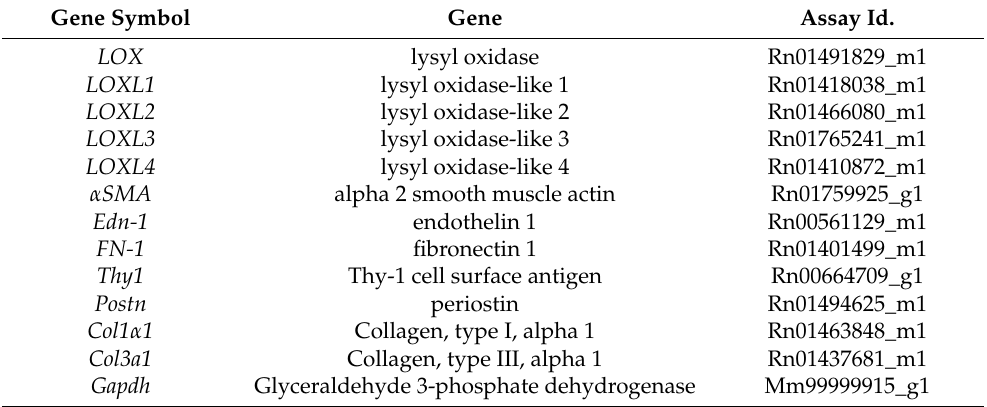
Table 1. Information on ABI TaqMan primer